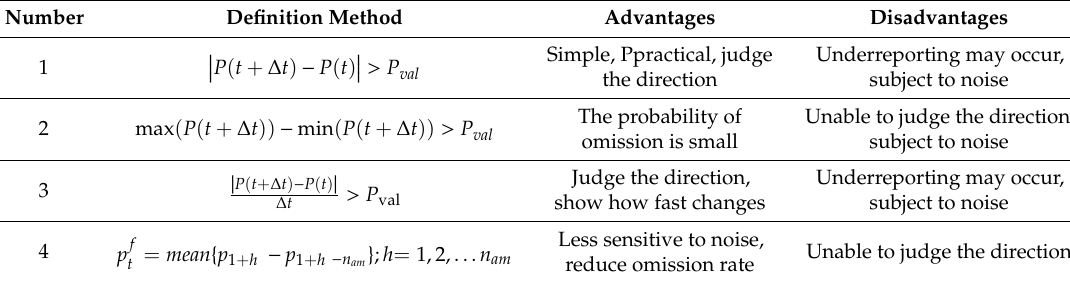
Table 1. Four existing definition